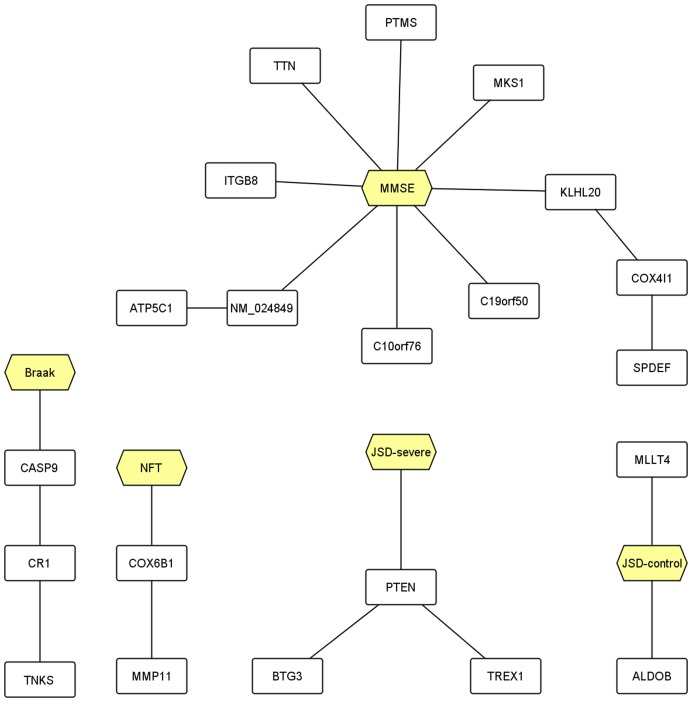
Visualization of the clustering outcome of the 1372-probe set signature.The figure shows only the clusters that contain the progression markers (hexagonal nodes). We note that the probe set for PTEN, whose product has been recently observed to localize with intracellular NFTs [36], has values that correlate strongly with the Jensen-Shannon divergence of the severe profile (JSDsevere).